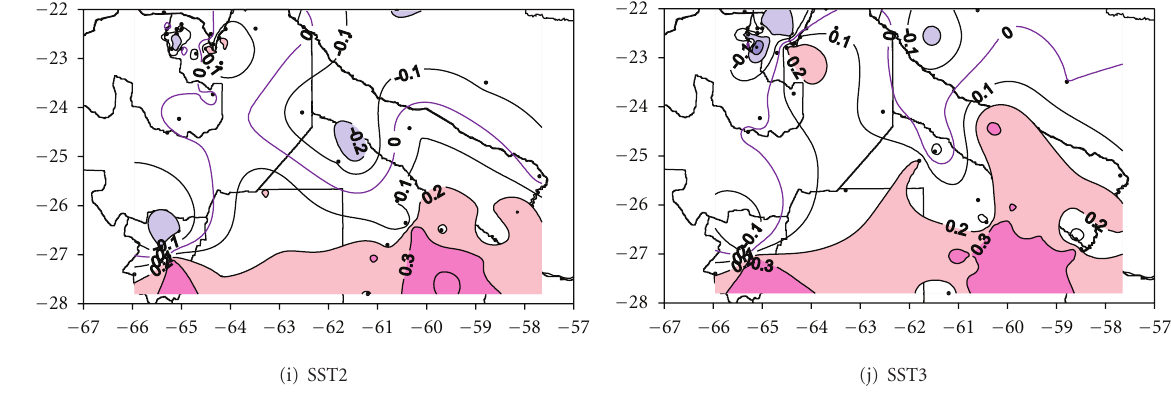
Figure 4: Idem Figure 3 for Autumn (MAM)